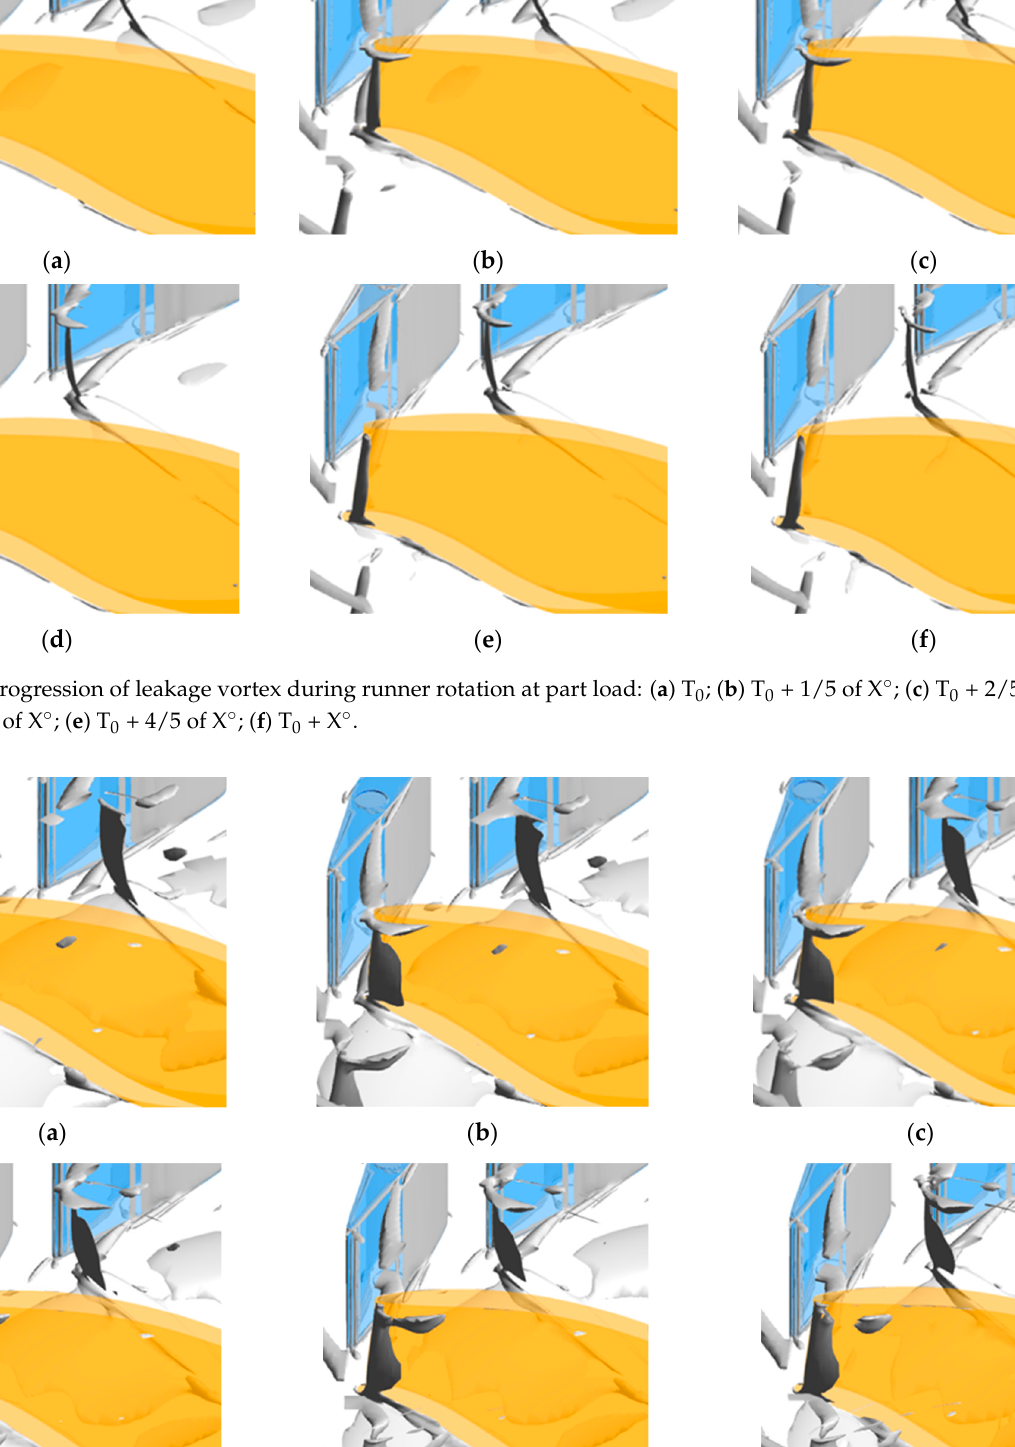
Figure 13. Progression of leakage vortex during runner rotation at full load: ( a ) T 0 ; ( b ) T 0 + 1/5 of X°; ( c ) T 0 + 2/5 of X°; ( d ) T 0 + 3/5 of X°; ( e ) T 0 + 4/5 of X°; ( f ) T 0 + X°.